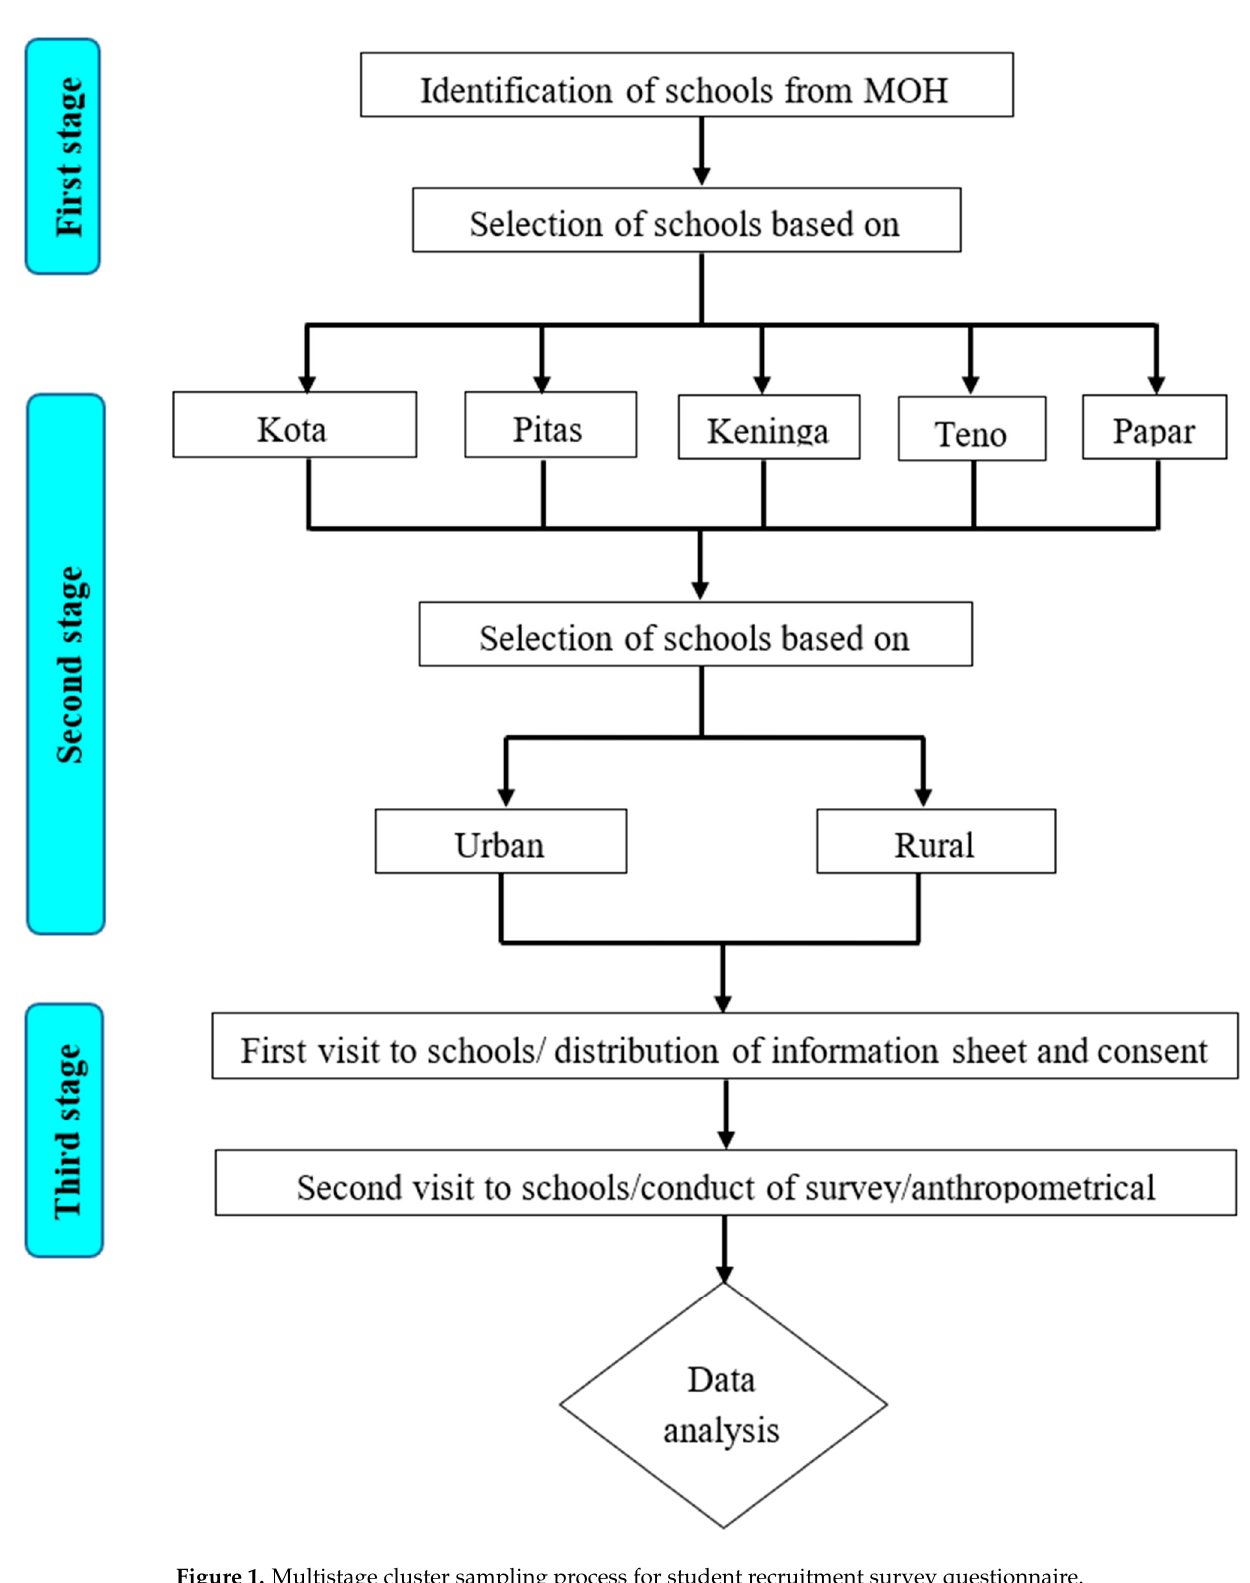
Figure 1. Multistage cluster sampling process for student recruitment survey questionnaire.